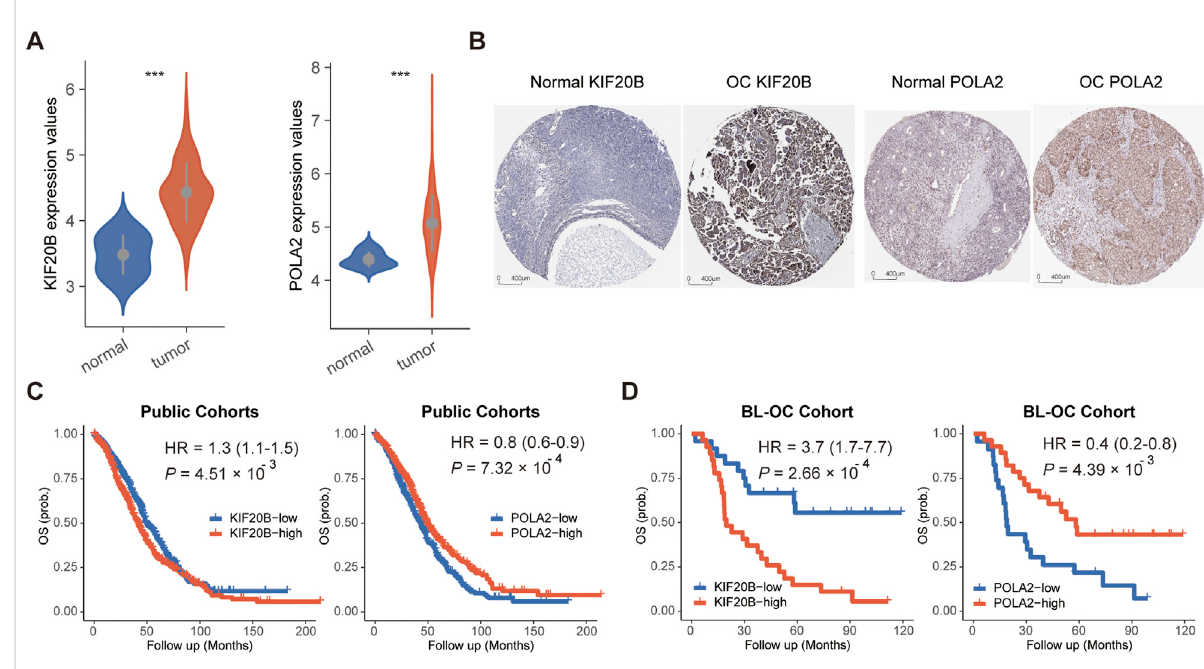
FIGURE 2 Expression and survival analyses for POLA2 and KIF20B in OC. (A) Expression levels of POLA2 and KIF20B in OC and normal tissues. (B) Protein levels encoded by POLA2 and KIF20B in normal and OC using clinical samples from the Human Protein Pro fi les. Survival analysis of POLA2 and KIF20B in public cohorts (C) and the BL-OC cohort (D)